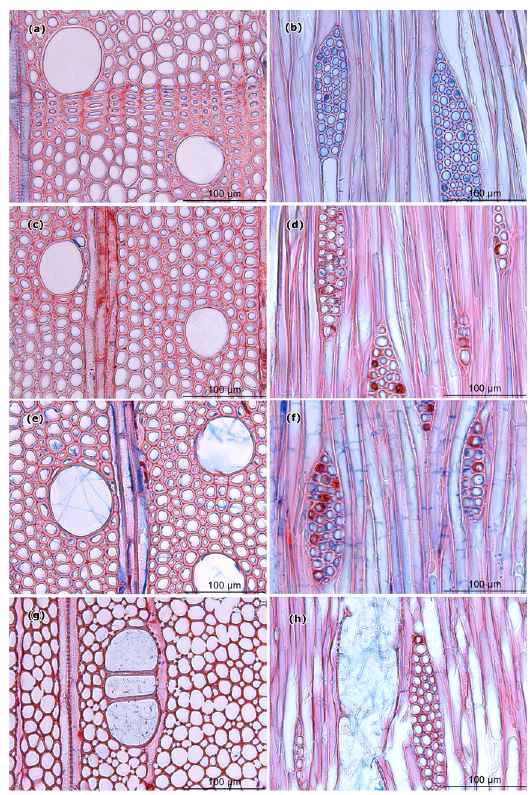
Figure 7. Light microscopy (LM) images of cross and tangential sections of ( a , b ) control samples and wood samples after 15 weeks of exposure to ( c , d ) EP34, ( e , f ) EP65, and ( g , h ) TV.